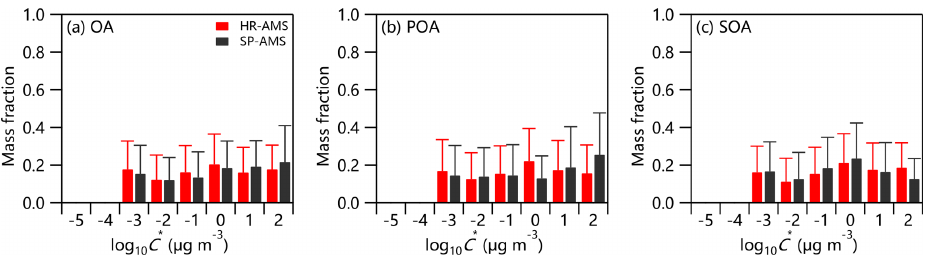
Figure 6. Predicted volatility distributions of OA, POA, and SOA measured by TD-HR-AMS and TD-SP-AMS in 2017. The error bars are the uncertainties derived using the approach of Karnezi et al. (2014).